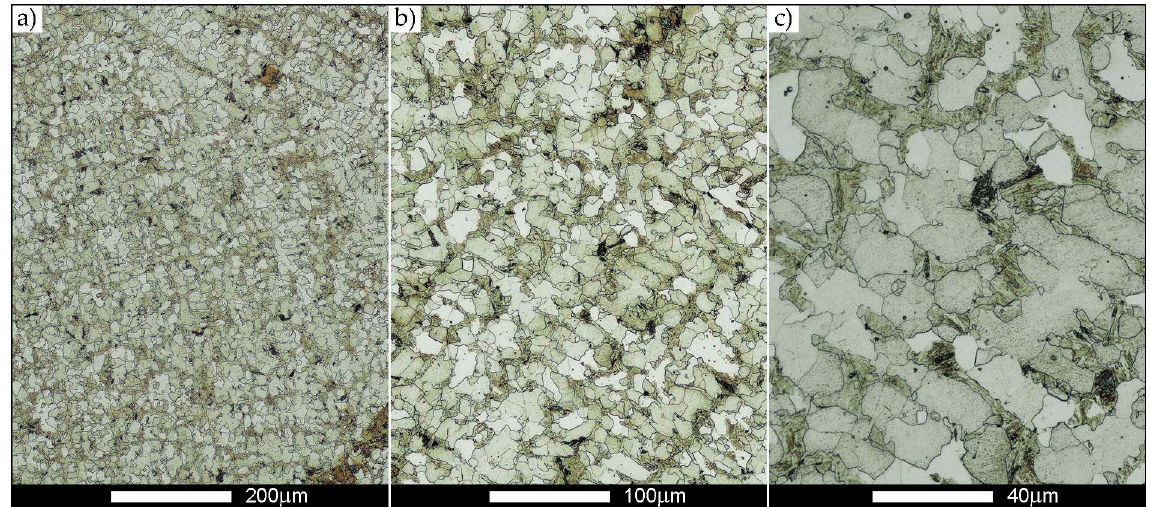
Figure 29. Welded joint microstructure of Hardox 450 in the delivery state (directly after welding) with revealed grain boundaries of prior austenite—WM1 zone shown in Figure 2. ( a ) 100×; ( b ) 200×; ( c ) 500×.